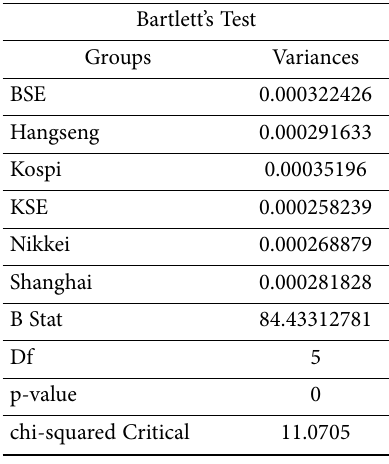
Table 5. Inferential Analysis (Bartlett’s